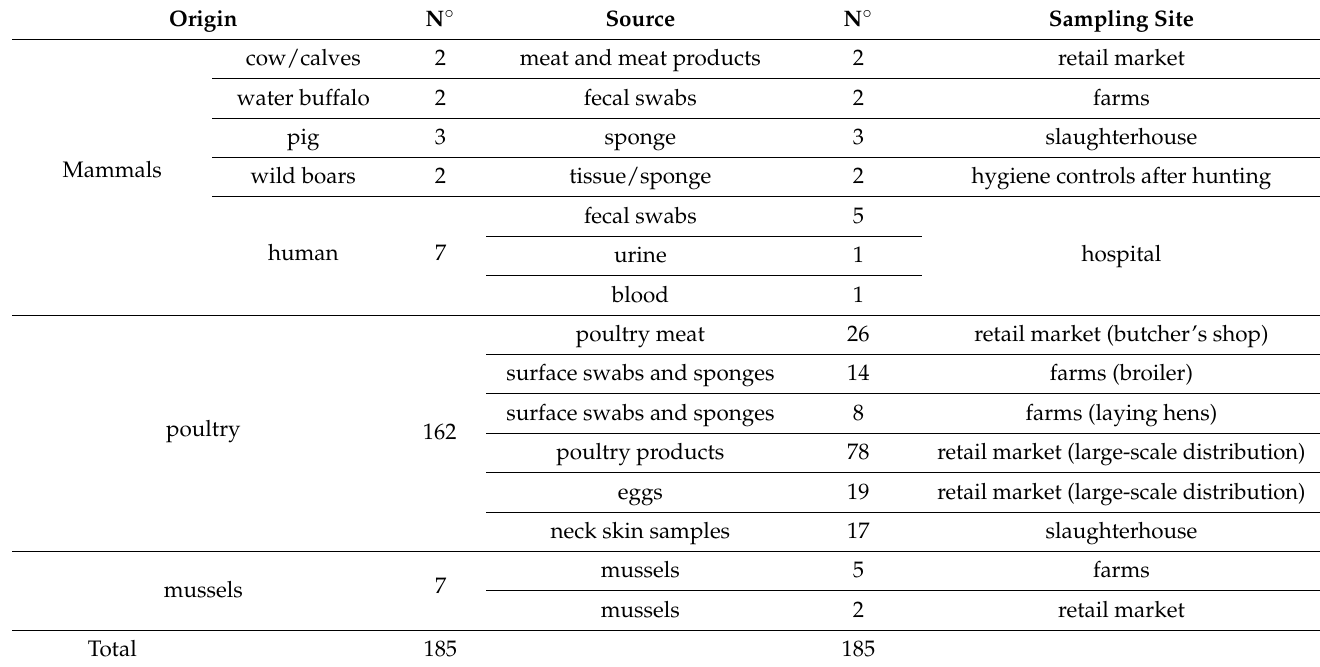
Table 1. Number (N ◦ ), source, and sampling site of Salmonella Infantis strains (n = 185) isolated between 2018 and